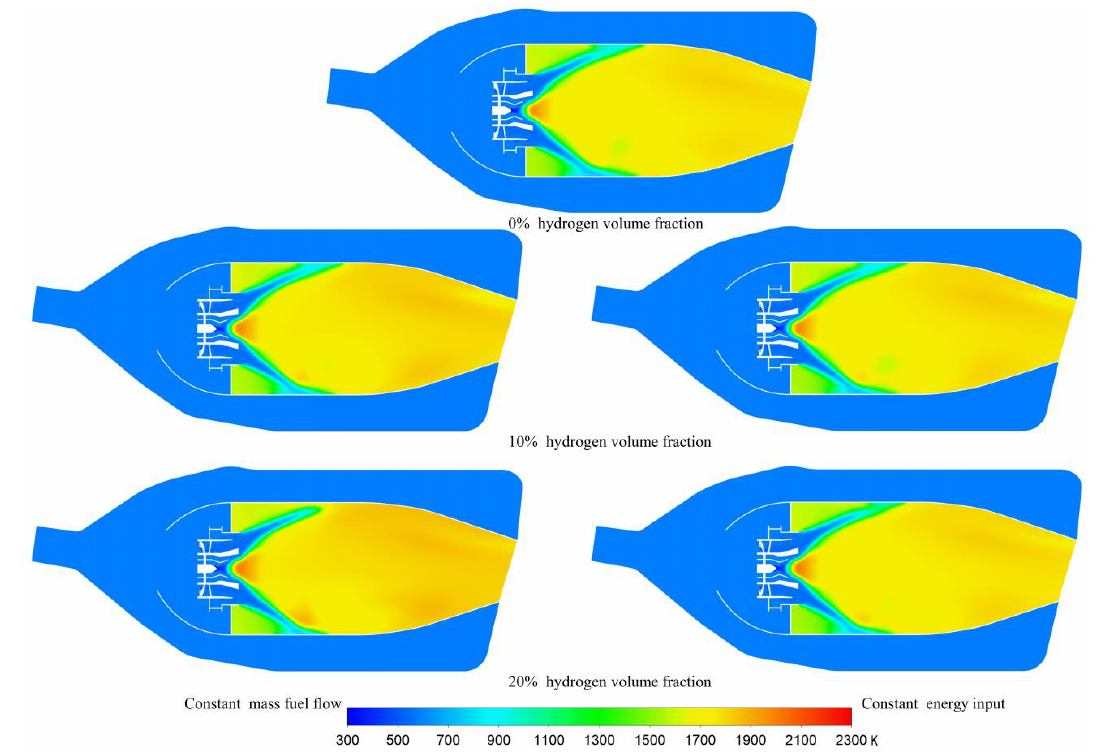
Figure 6. Temperature distribution under different hydrogen volume fractions.